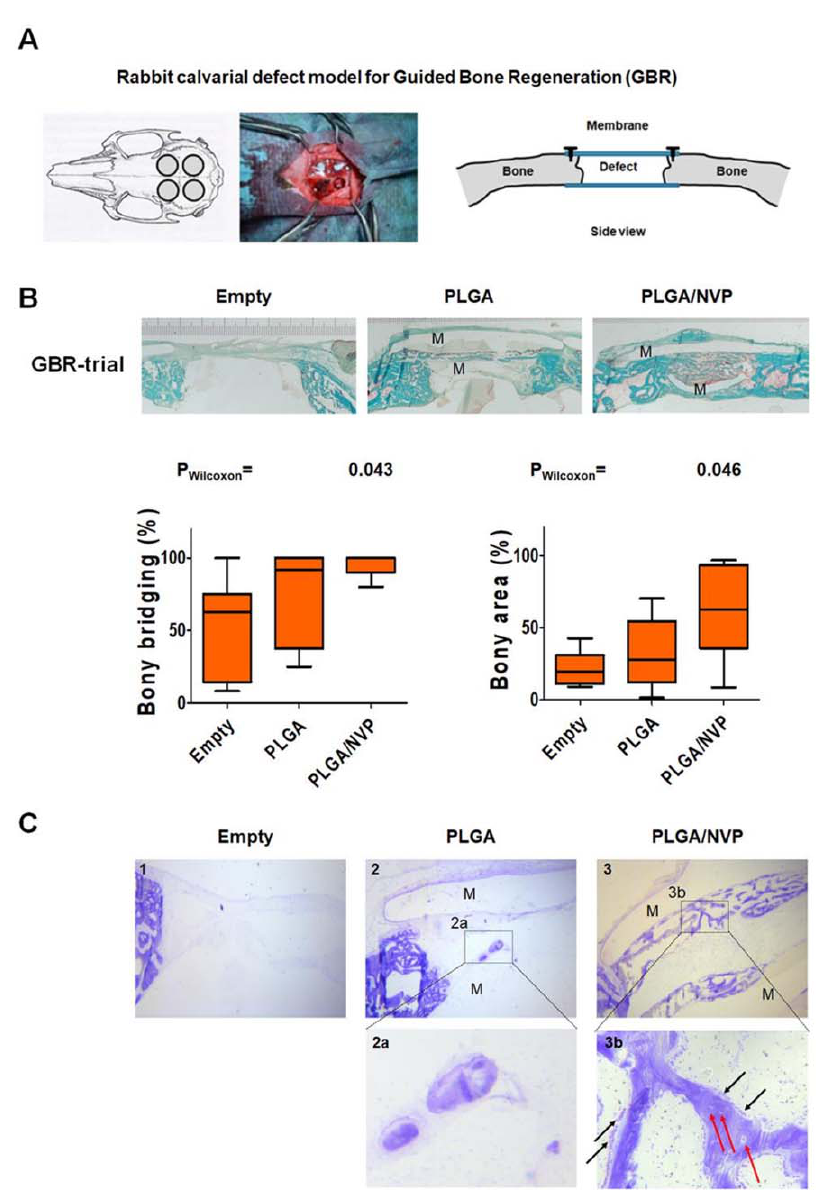
Figure 7. In vivo experiment with a NVP-loaded membrane. ( A ) Rabbit calvarial defect model for Guided Bone Regenera- tion (GBR). ( B ) Six New Zealand white rabbits were used in this study ( n = 6). Goldner’s Trichrome staining and analysis of bone regeneration parameters of calvarial defects, control defect (Empty), defect treated with native PLGA membranes (PLGA), and defect treated with PLGA membranes loaded with NVP at 10% by vapor deposition (PLGA/NVP). M marks the transparent layer of the membranes placed above and below the defect. Trichrome stains the bone in a greenish-blue color and the osteoid in red. Results for bony bridging and bony regenerated area are displayed as box plots ranging from the 25th (lower quartile) to the 75th (upper quartile) percentile, including the median as a solid black line and whiskers showing the minimum and maximum values ( p values are provided). ( C ) Histology of the calvaria defect. The micrographs show nondemineralized toluidine blue-stained sections of calvaria defects. There is no visible bone formation when the defect is left untreated ( 1 ). In the presence of a native PLGA membrane, there is no obvious bone formation in the middle of the defect except a bone-like structure with no visible osteoblast ( 2, 2a ). However, bone formation begins on both sides of the defect. A significant bone formation is observed on the whole defect area when the NVP loaded membranes are used to cove the defect ( 3 ). At high magnification, the presence of bone-forming surface with a wide unmineralized osteoid seam lined by osteoblasts (black arrows in 3b ) as well as osteocytes (red arrows in 3b ). [Magnification. ( 1 – 3 ): 20 × ; (2 a ,3 b ): 40 ×